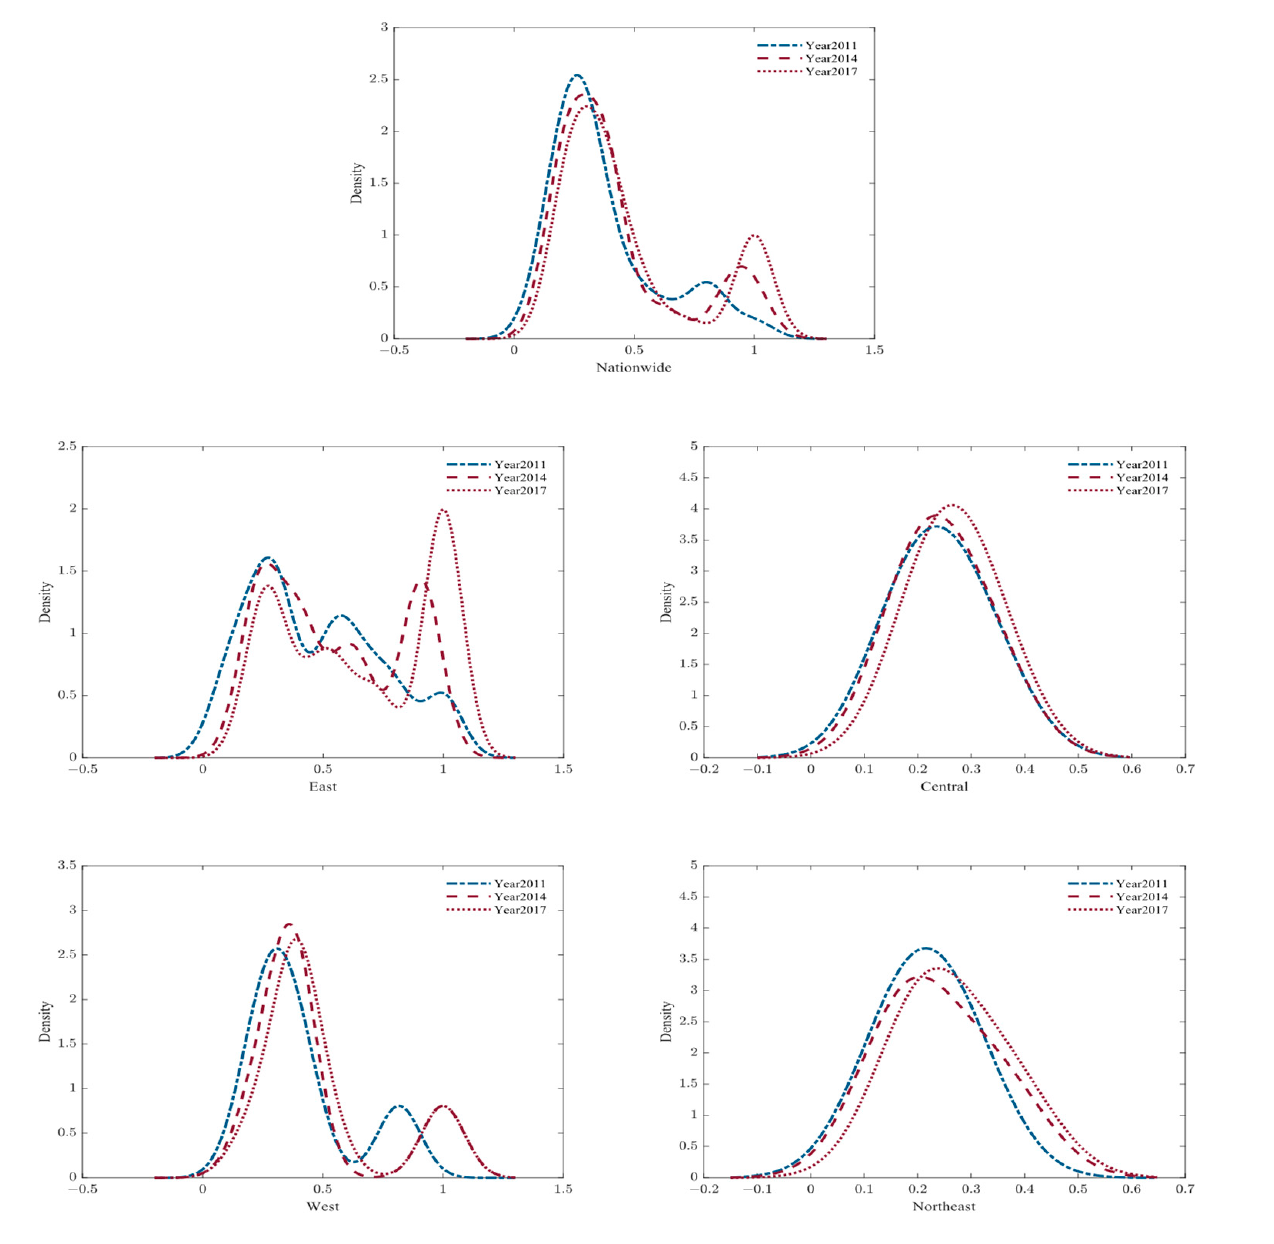
Figure 3. Distribution of SLUE density by region.